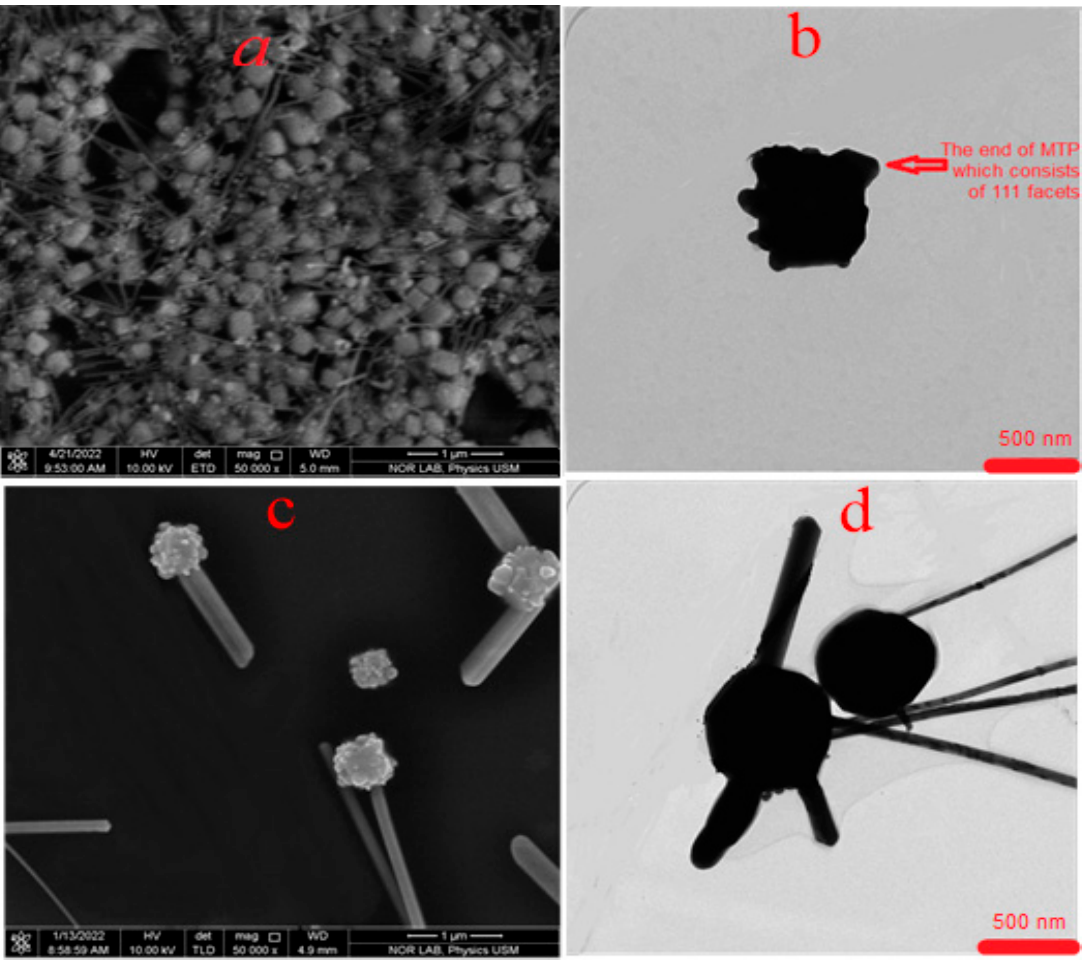
Figure 6. ( a ) and ( c ) are FESEM images of AgNPs and AgNRs suspensions grown at 140 °C for 125 Figure 6. ( a , c ) are FESEM images of AgNPs and AgNRs suspensions grown at 140 ◦ C for 125 min min and 175 min, respectively, and the corresponding ( b ) and ( d ) are their TEM images. and 175 min, respectively, and the corresponding ( b , d ) are their TEM